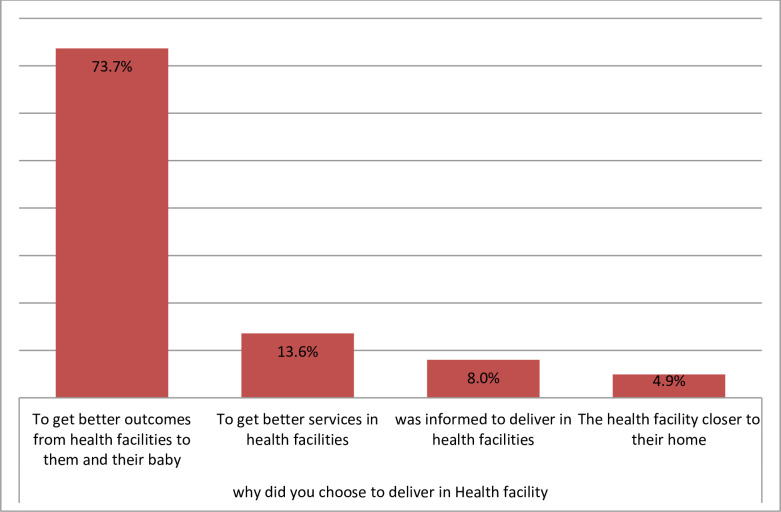
Reasons of women utilized institutional delivery service among study subjects in Mandura district, 2019.